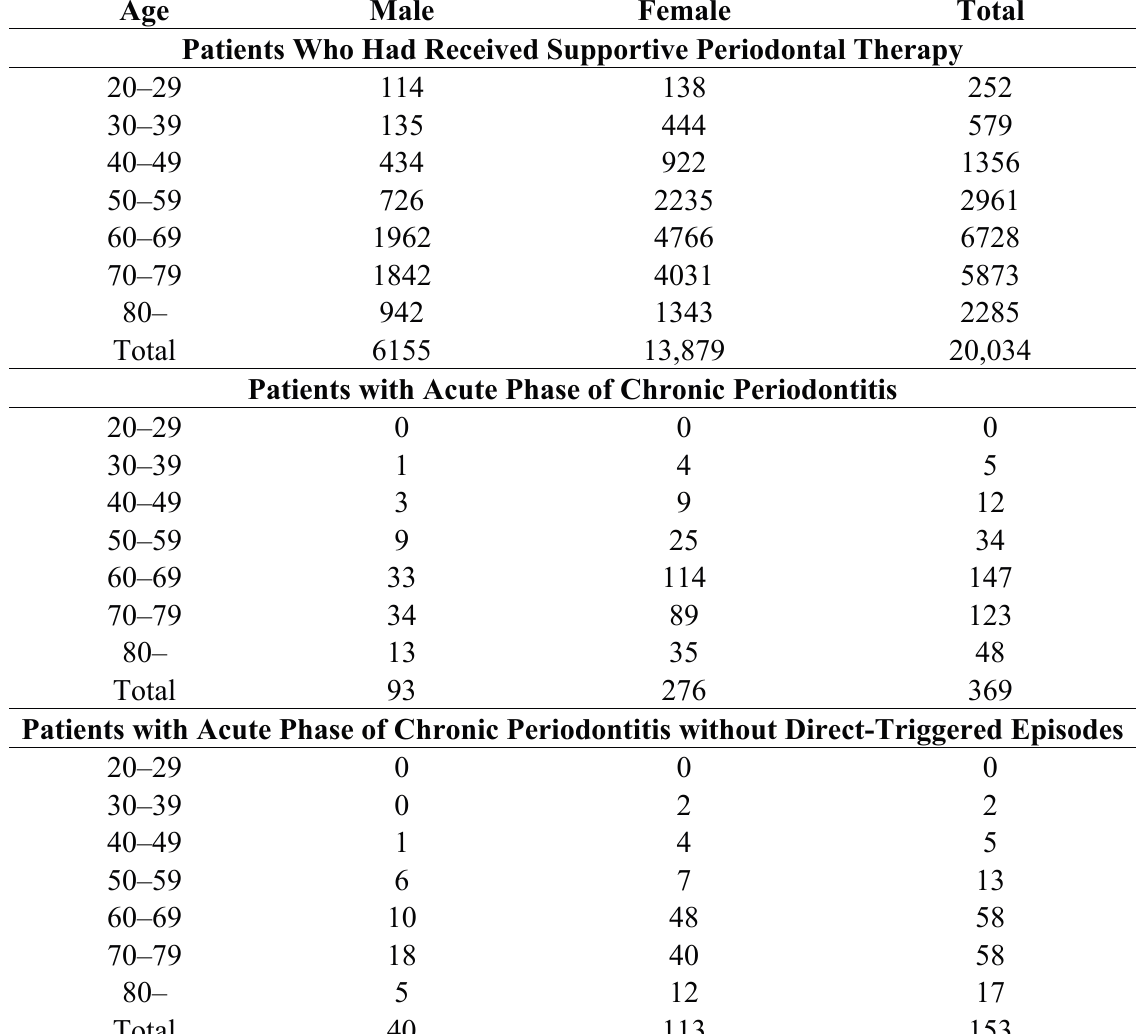
Table 1. Characteristics of the study